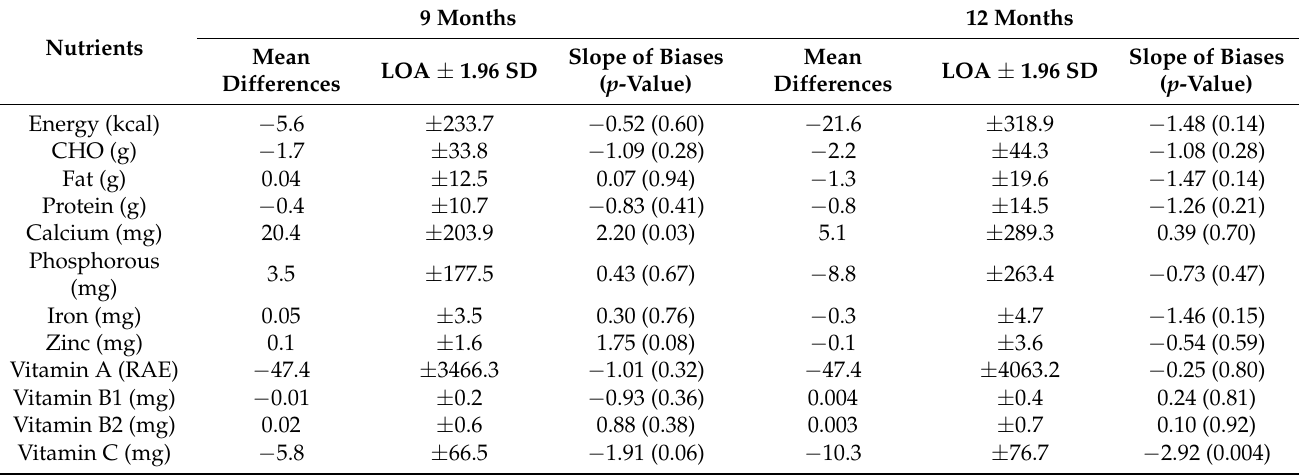
Table 4. Bland–Altman